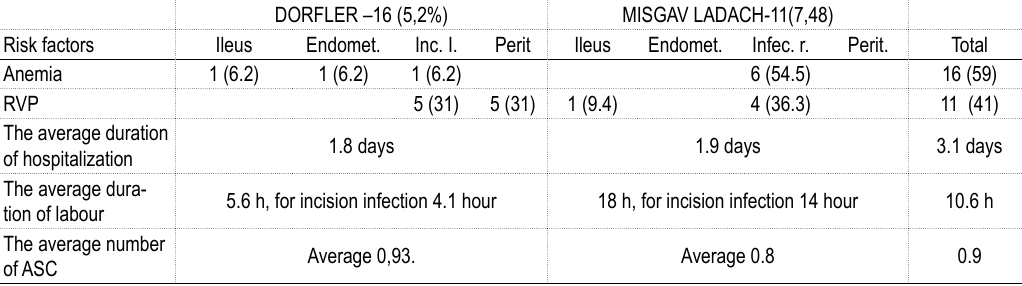
(rVP= premature rupture of membranes,